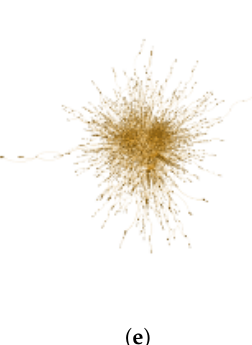
Figure 2. Analysis of the network topology for the five largest sub-communities indicates different sub-networks. ( a ) SC1 is dominated by campaign accounts and high profile campaigners. ( b ) SC2 includes US presidential election candidates, media coverage, and supporters of those candidates. ( c ) SC3 is dominated by political parties and high profile politicians. ( d ) SC4 largely reflects media coverage of the Brexit campaign. ( e ) SC5 is dominated by discussion of Scotland